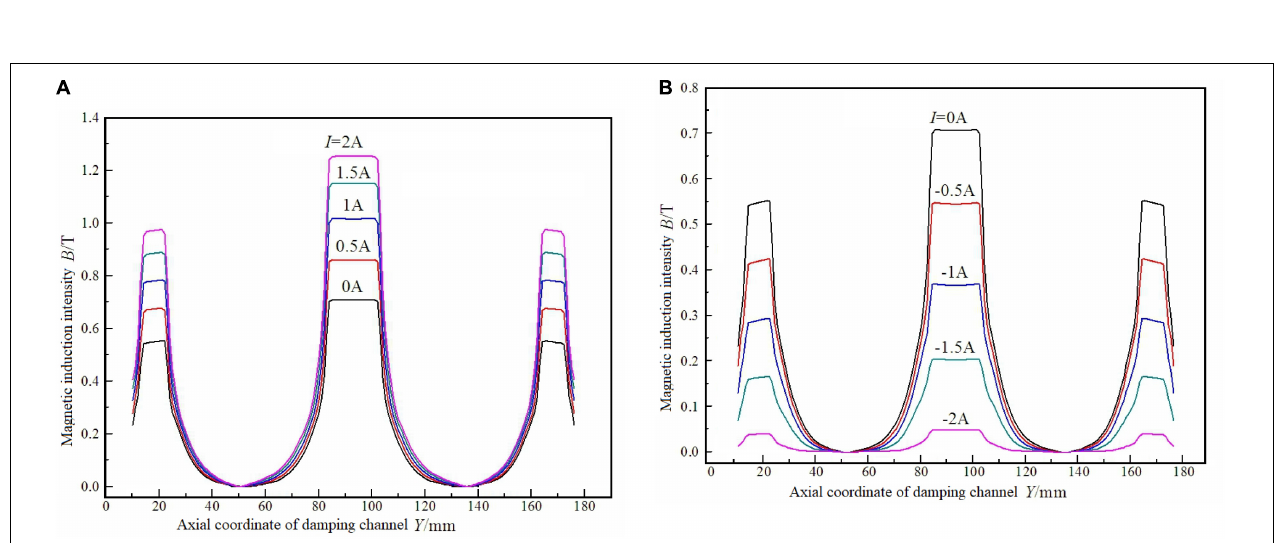
FIGURE 4 | Magnetic induction intensity at working clearance of subpiston. (A) Current I is positive. (B) Current I is negative.